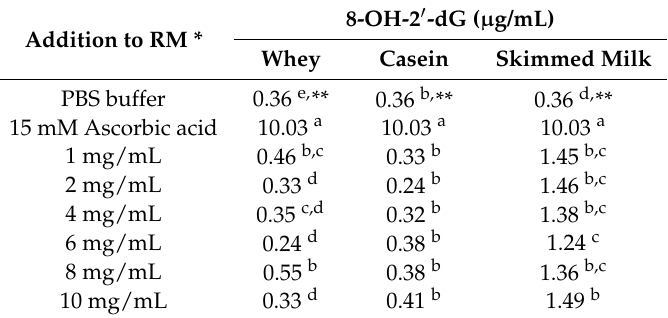
Table 1. Effect of bovine colostrums protein on the oxidation of 2 ′ -dG to 8-OH-2 ′ -dG induced by Fenton reaction.